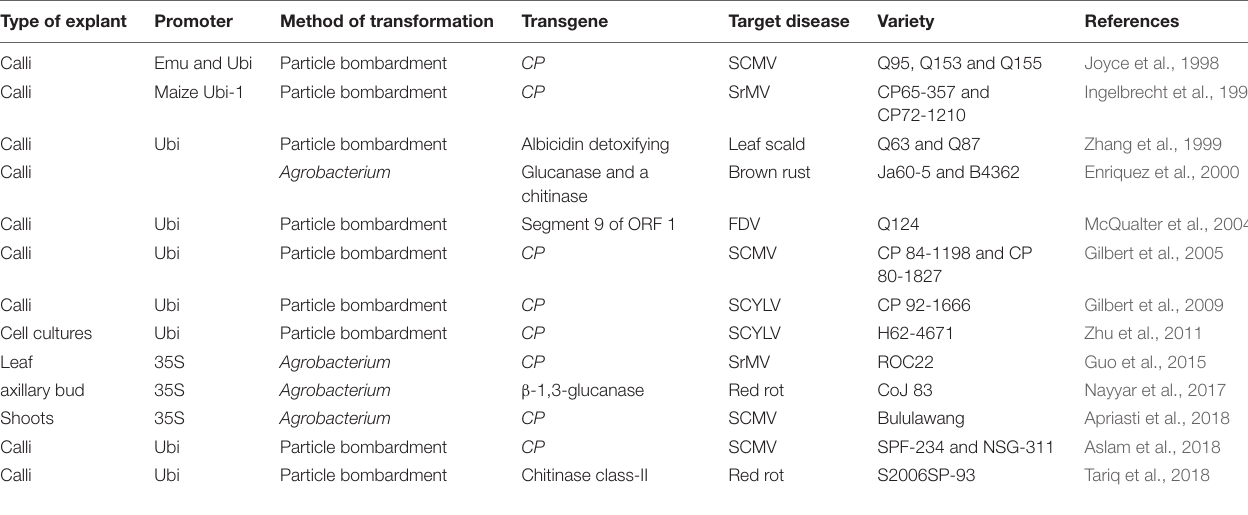
TABLE 2 | List of transgenic sugarcane engineered for disease